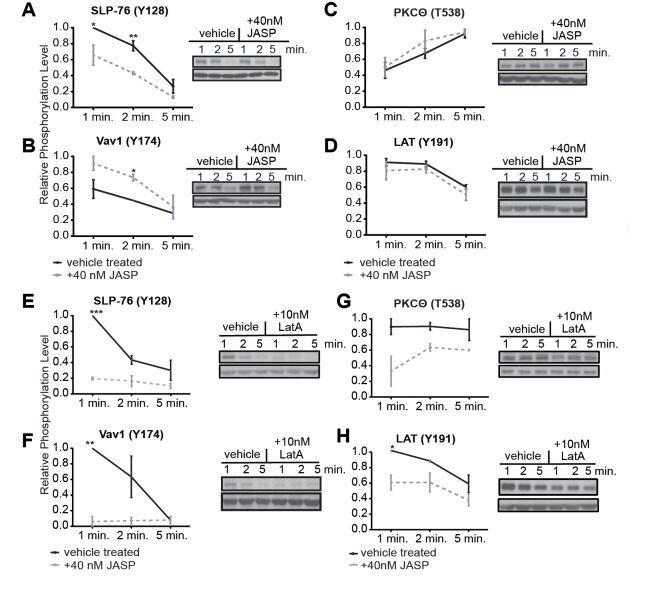
Low dose JASP treatment selectively affects lamellal signaling.(A-D) 5C.C7 T cells were activated with CH27 APCs (10μM MCC) with vehicle (solid black) or 40nM Jasplakinolide (broken grey). Phosphorylation levels for (A) SLP-76, (B) Vav1, (C) PKCθ, and (D) LAT were determined after 1, 2, and 5min. Graphs depict phosphorylation levels normalized to the max value jointly for control and Jasplakinolide treatment (at least 3 independent experiments). Corresponding representative immunoblots are adjacent to each graph. Complete blots are given in S2A–S2D Fig
(E-H) 5C.C7 T cells were activated with CH27 APCs (10μM MCC) with vehicle (solid black) or 10nM LatA (broken grey). Phosphorylation levels for (E) SLP-76, (F) Vav1, (G) PKCθ, and (H) LAT were determined after 1, 2, and 5min and are given as in A-D. Complete blots are given in S2G–S2J Fig Error bar are s.e.m.. Significance was determined by Student’s t-test and is indicated by asterisks (*p<0.05,**p<0.001,***p<0.0001).